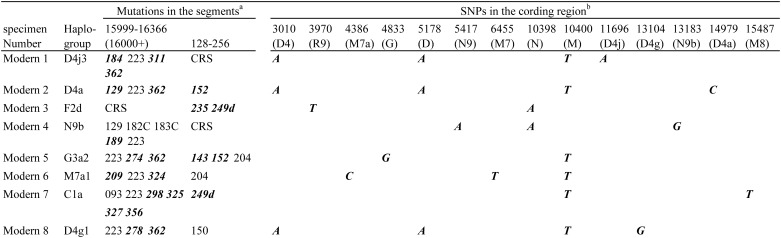
Nucleotide changes observed in modern-day DNA samples.aAll polymorphic sites are numbered according to the rCRS [18]. CRS denotes that the sequence of the segment is identical to the rCRS. The suffix A indicates a transversion, and d indicates a deletion. Deletions are recorded at the last possible site. Diagnostic polymorphisms are emphasized by bold italic type. bAll polymorphic sites are numbered according to the rCRS. Diagnostic polymorphisms are emphasized by bold italic type. The sites that did not show polymorphisms are omitted.